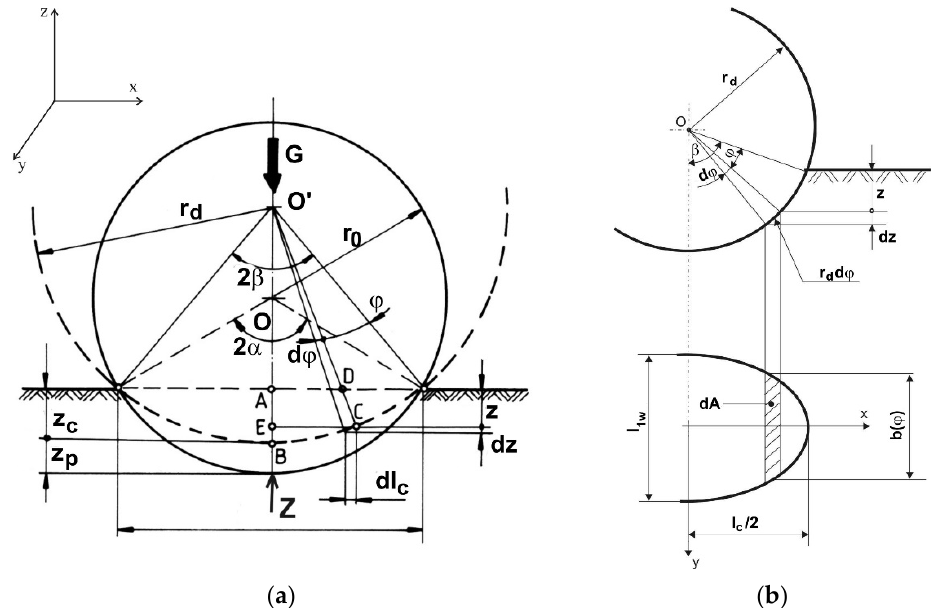
Figure 1. Schematics of the model [10]: ( a ) tire and soil deformation; ( b ) contact patch; z p —tire deflection under load; z c —tire sinkage into the soil; l c —length of the contact patch; l 1w —width of the contact patch; G—vertical load; r 0 —radius of unloaded tire; r d —radius of loaded tire, in the contact area; α , β —contact angles; φ —current angle.